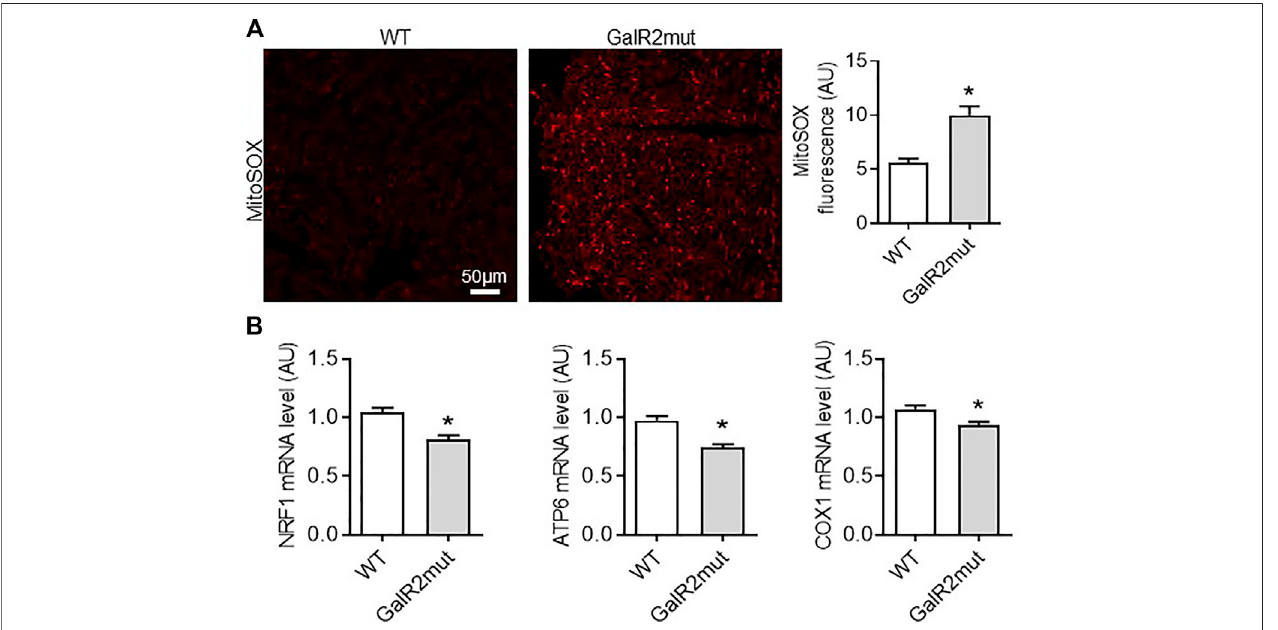
FIGURE3| Cardiac mitochondrial ROSstatus in GalR2 de fi cient mice. (A) Representative images and quanti fi cation ofcardiac sections stainedwith MitoSox Red from WT and GalR2mut mice, n = 4 – 6 mice. (B) Myocardial mRNA levels of NRF1, ATP6 and COX1 in WT and GalR2mut mice, n = 5 – 7. Data represents the mean ± SEM. * p < 0.05 vs.